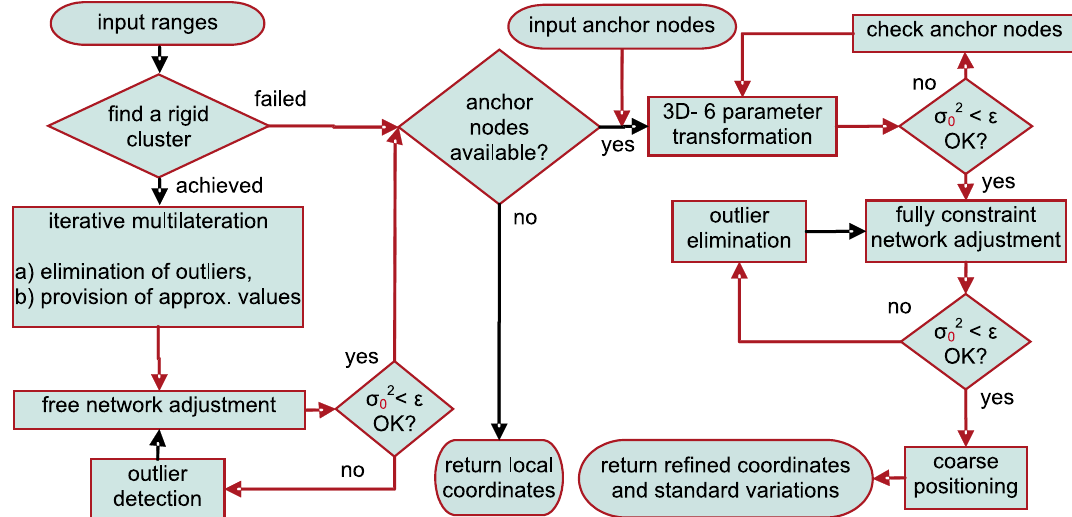
Fig. 3. Start-up of the geodetic positioning mode, which does not require any initial approximate coordinates. σ 02 is the a posteriori reference variance, which is compared with a